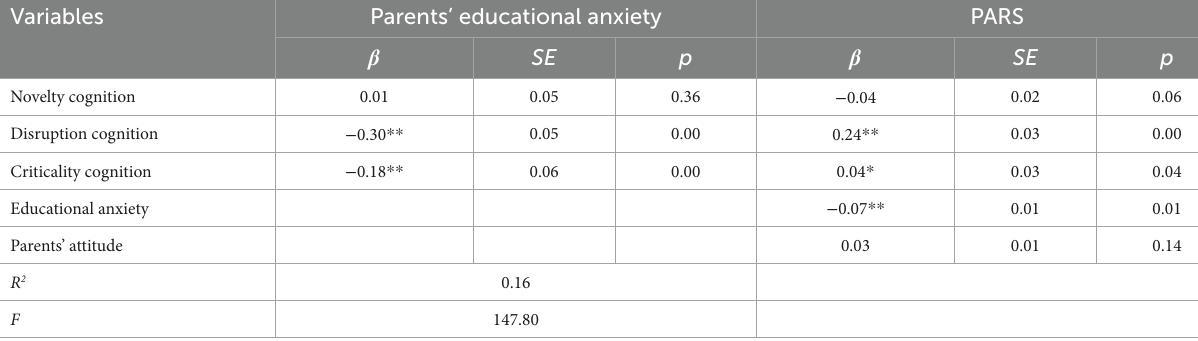
TABLE 3 Main effects hypothesis